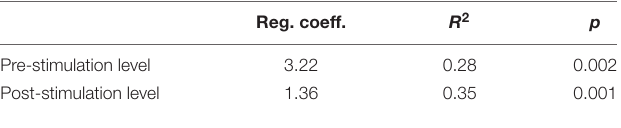
TABLE 5 | Regression coefficients for HRV-HF levels (linear regression model was used).